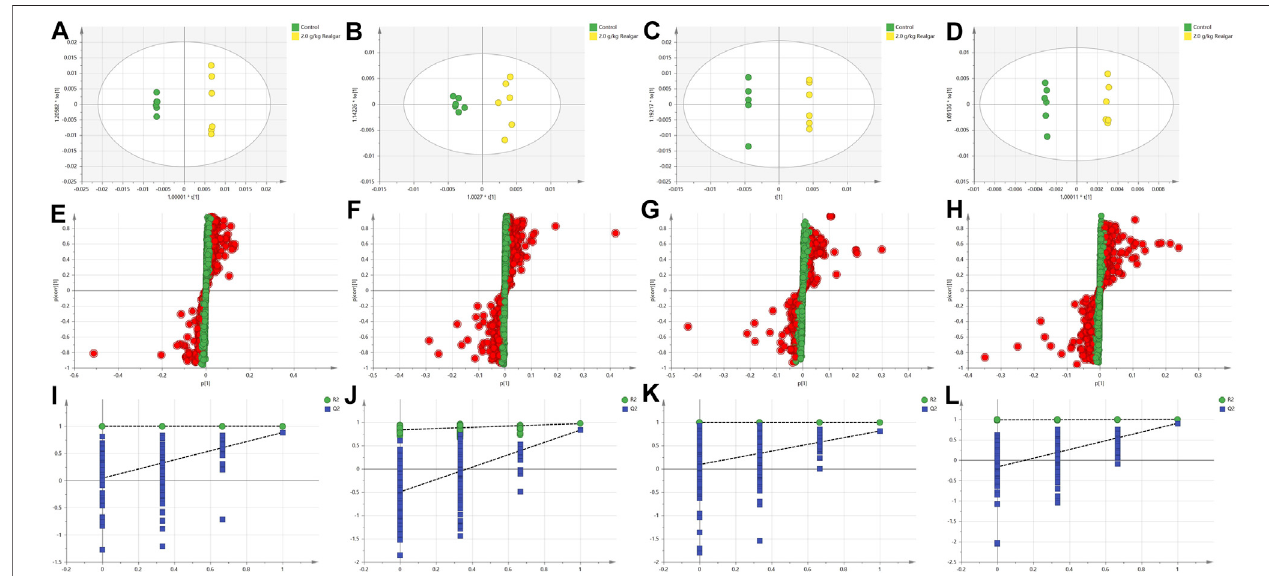
FIGURE3| OPLS-DAanalysis[ (AandB) ofthepositiveandnegativeionmodesofserumsamples,respectively; (CandD) ofthepositiveandnegativeionmodes ofthe kidney samples,respectively],Permutation test results [ (E and F) ofthe positiveand negative ion modes ofserum samples, respectively; (G and H) ofthe positive and negative ion modes of the kidney samples, respectively], and S-plot (I and J ofthe positive and negativeion modes ofserum samples, respectively; (K and L) of the positiveand negative ionmodes ofthekidneysamples,respectively).Themodels withthe statistical parameters asfollows: (A) R2X (cid:2) 0.768,R2Y (cid:2) 1,Q2 (cid:2) 0.884; (B) R2X (cid:2) 0.434,R2Y (cid:2) 0.973,Q2 (cid:2) 0.834; (C) R2X (cid:2) 0.897,R2Y (cid:2) 1,Q2 (cid:2) 0.814; (D) R2X (cid:2) 0.654,R2Y (cid:2) 0.999,Q2 (cid:2) 0.904; (I) R2inter (cid:2) 0.999,Q2inter (cid:2) 0.0432; (J) R2 inter (cid:2) 0.828, Q2 inter (cid:2) − 0.494; (K) R2 inter (cid:2) 0.1, Q2 inter (cid:2) 0.0944; (L) R2 inter (cid:2) 0.99, Q2 inter (cid:2) −